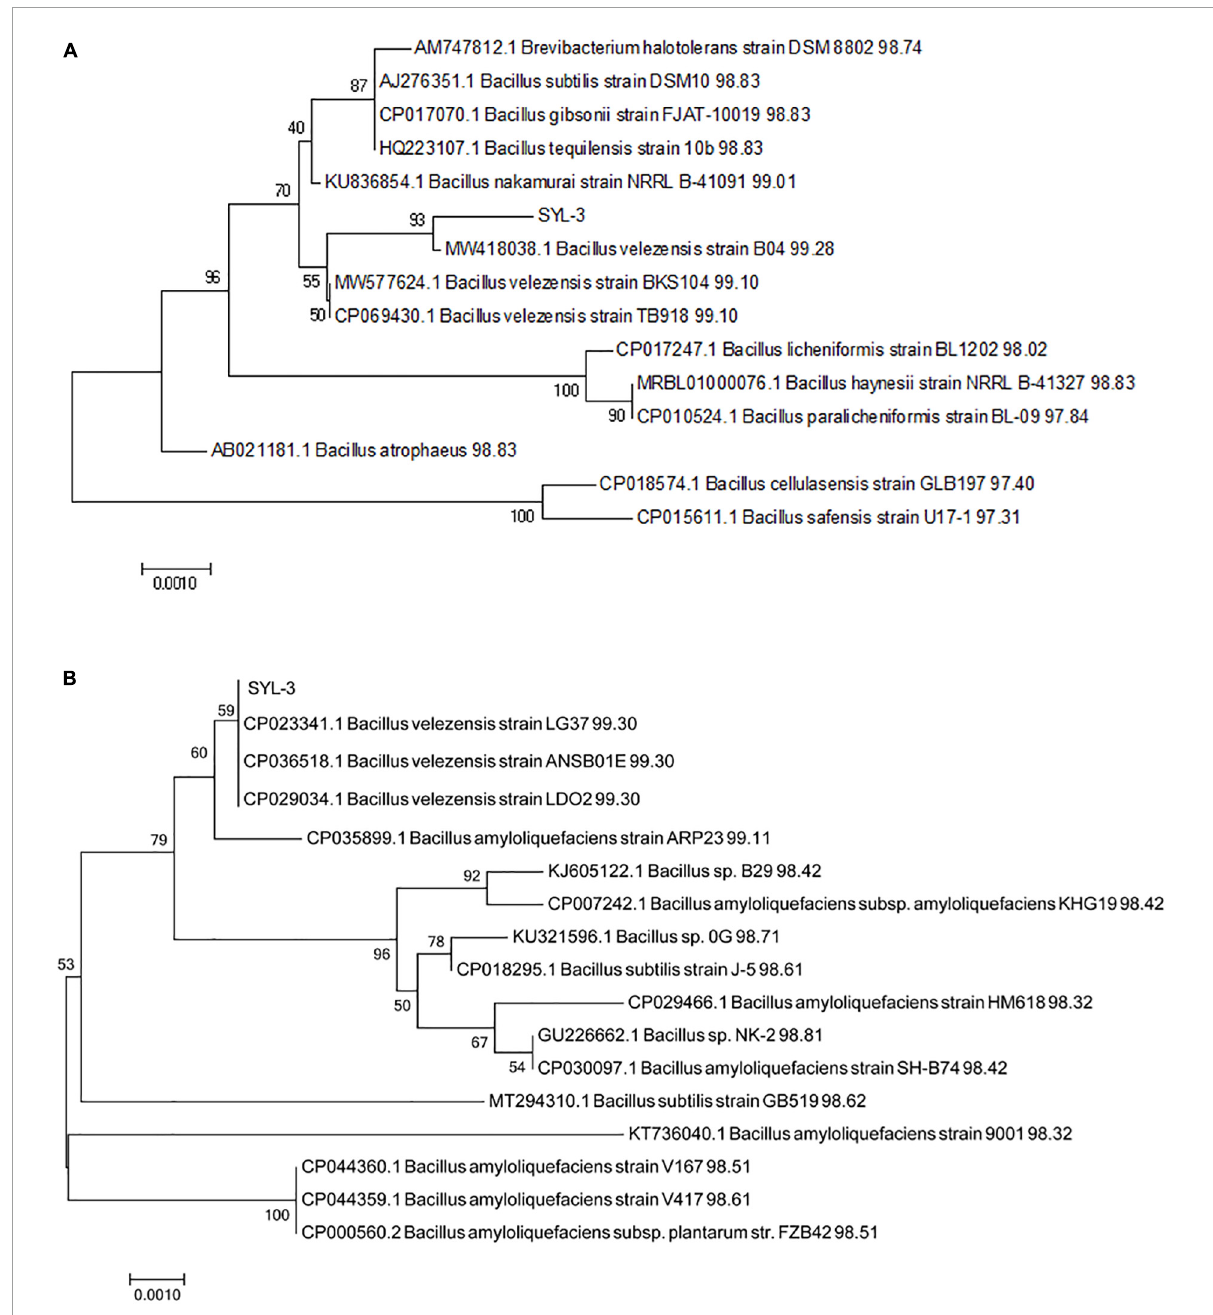
FIGURE2 Phylogenetic analysis of strain SYL-3 based on the sequences of 16s rRNA (A) and gyrA (B) . The tree was constructed using the neighbor-joining algorithm with 1,000 bootstrap replications.